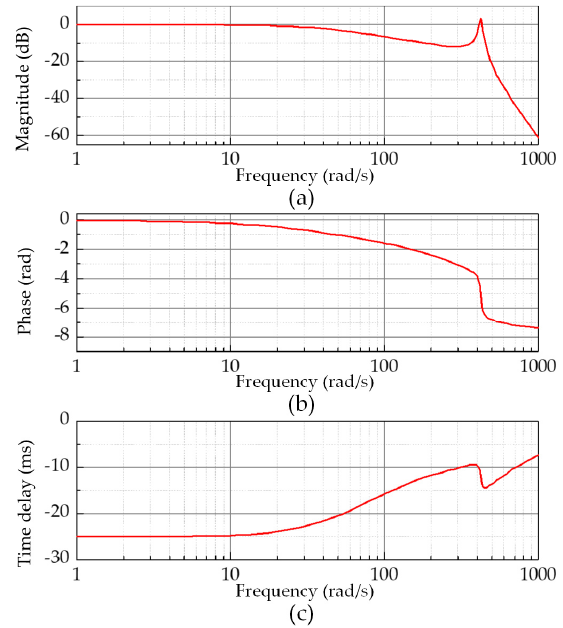
Figure 2. Magnitude, phase, and time delay of the nominal control plant. ( a ) Magnitude; ( b ) phase; ( c ) time